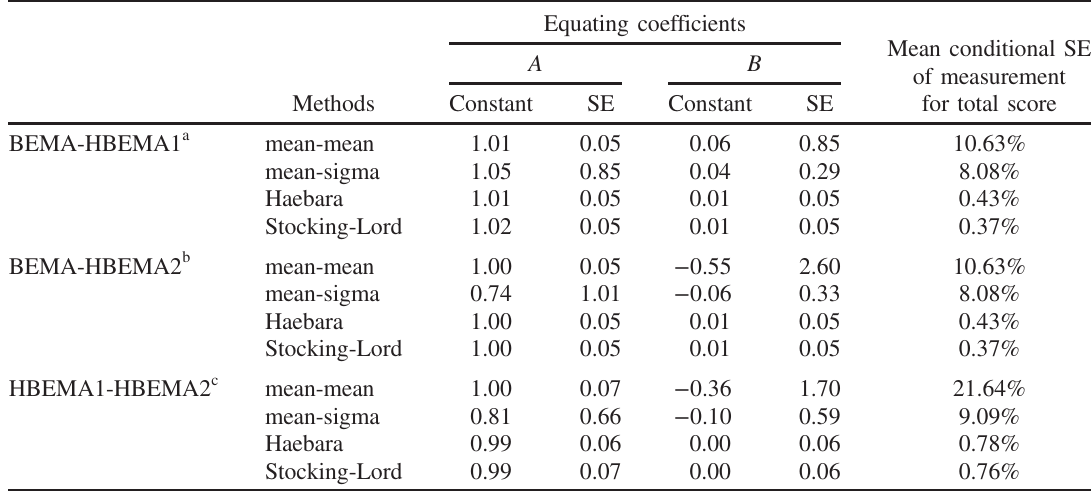
TABLE III. Summary of equating three versions of BEMA using four equating